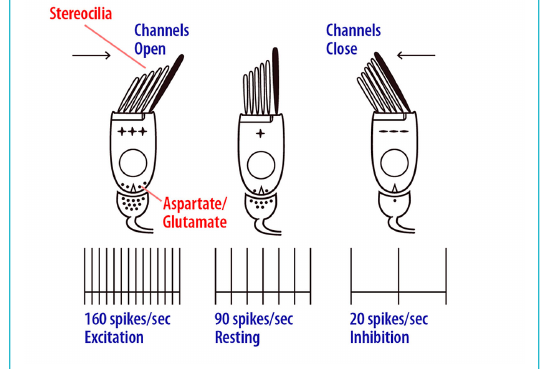
Figure 2: Illustration of the transduction process in the vestibular system. Hair cells transform mechanical vibrations (i.e., head motion) into electrical signals that modulate the baseline firing rate of the primary sensory neurons. Reproduced from Ange- laki D, Dickman JD. The vestibular system. In: Biswas-Diener R, Diener E, eds. Noba textbook series: Psychology. Champaign, IL: DEF publishers; 2018. (Copyright © 2018 Diener Education Fund; Creative Commons Attribution-NonCommercial-Share Alike 4.0 In- ternational